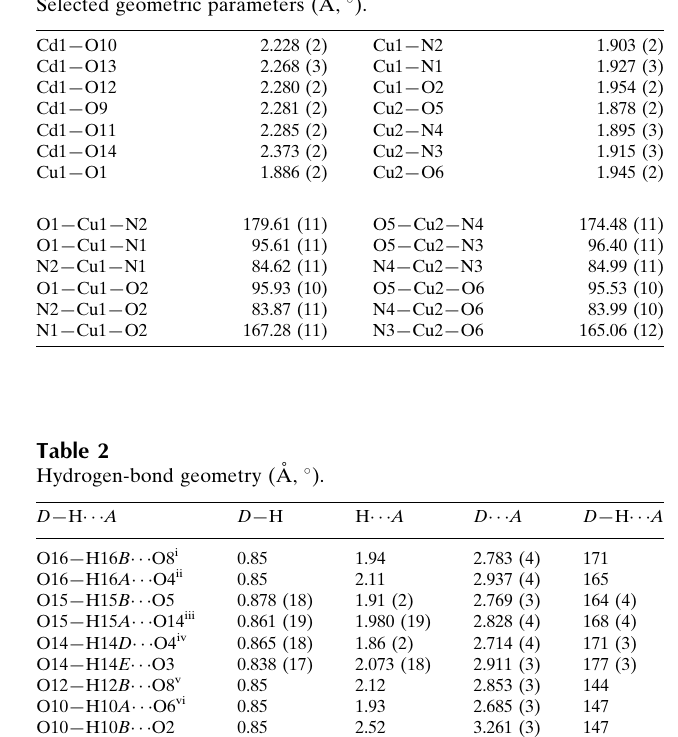
Selected geometric parameters (A˚ , (cid:3) ).